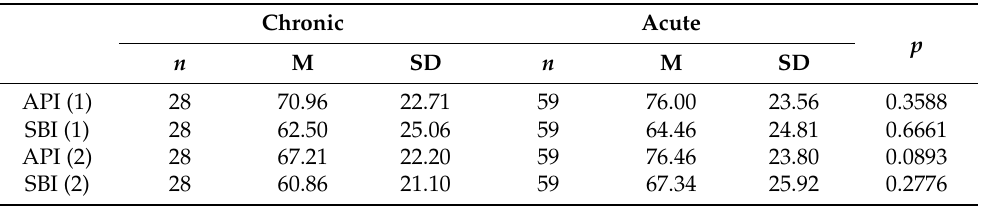
Table 9. The association between periodontal indices before (1) and after (2) chemotherapy versus type of leukemia (chronic and